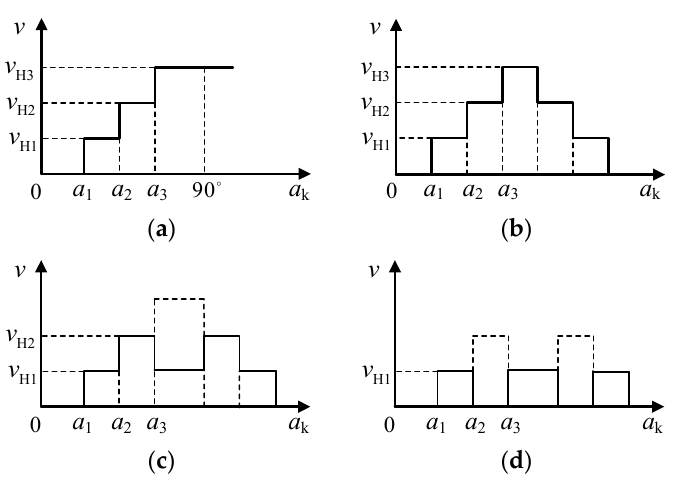
Figure 2. Multiband SHEPWM waveform for a multilevel inverter: ( a ) schematic diagram of a seven-level phase voltage; ( b ) waveform of a seven-level inverter under model A; ( c ) waveform of a seven-level inverter under model B; ( d ) waveform of a seven-level inverter under model C.